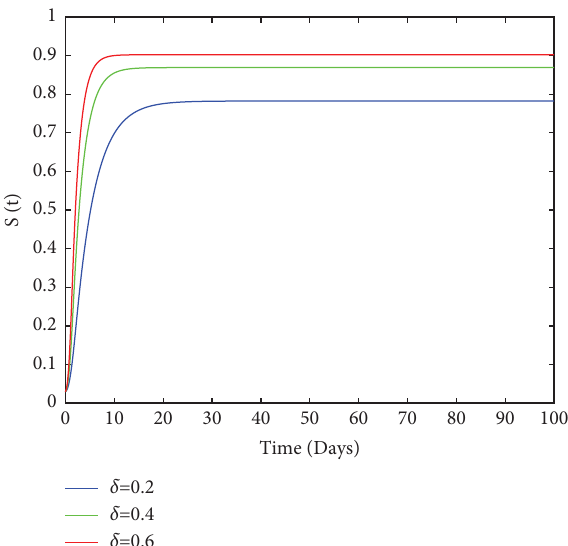
Figure 7: Te density of knowledge disseminators varies with the value of δ